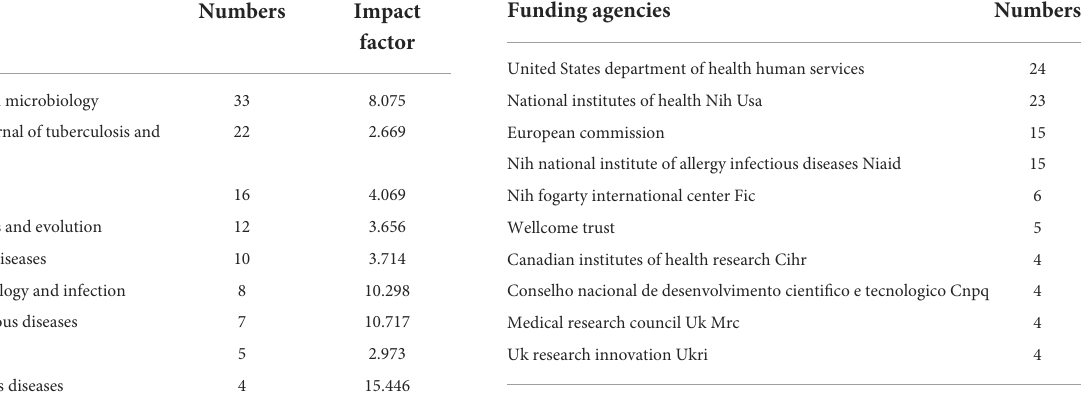
TABLE 2 Top 10 funding agencies of tuberculosis molecular